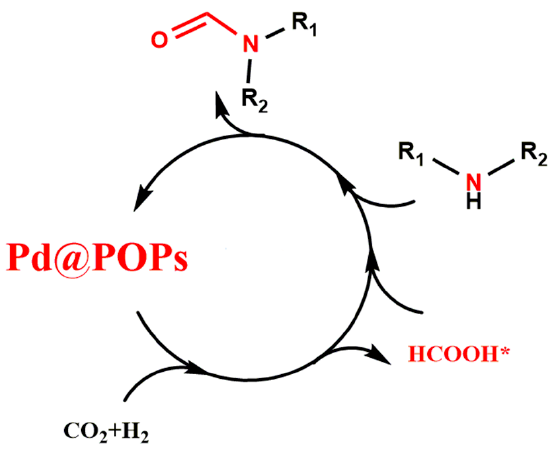
Figure 5. The possible mechanism of the N-formylation reaction.